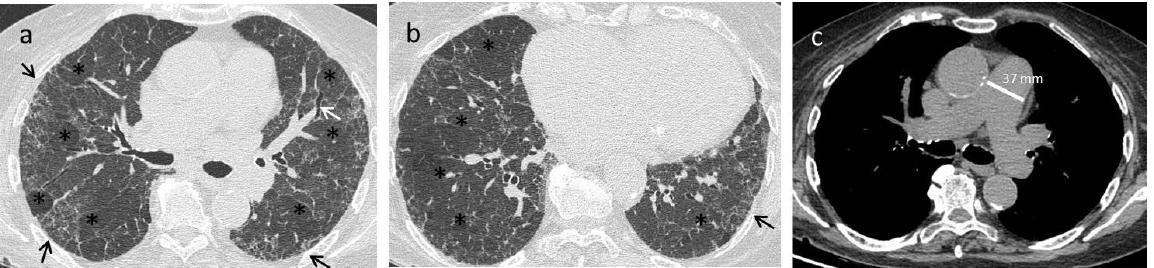
Figure 4. Pulmonary Hypertension. An 82-year-old female with a diagnosis of SSc. Axial High Resolution CT images show extensive subpleural reticulations (black arrows) and traction bronchiectasis/bronchiolectasis (white arrows), compatible with a UIP probable pattern ( a , b ). Signs of pulmonary hypertension, a common complication of this disease, can also be appreciated. On high resolution CT scan there is diffuse mosaic attenuation (*) with enlarged peripheral vessels ( a , b ), and a dilatation of the main pulmonary artery can be recognized using the mediastinal window setting ( c ).